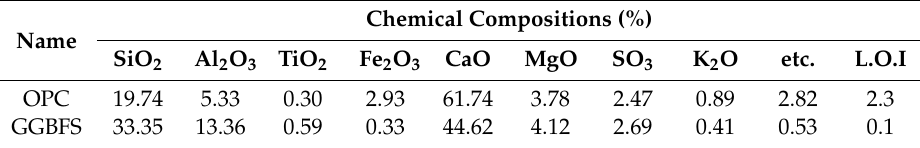
Table 1. Chemical compositions of cement and ground granulated blast furnace slag